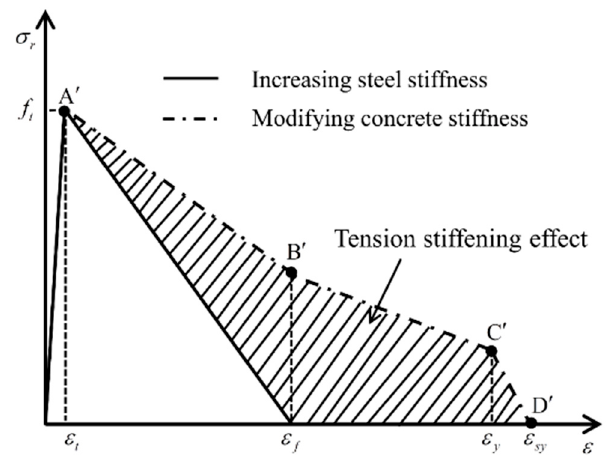
Figure 9 is the stress-strain curve of reinforced concrete. The shadow part contributes to the stiffness of the tensile stiffener effect. Equation (19) is the stress-strain curve of